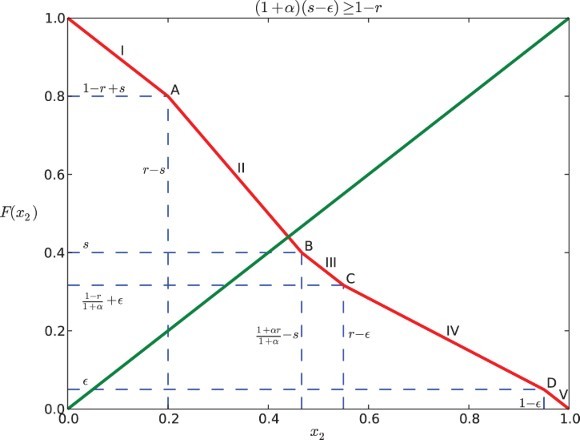
Return map F for Case II when α=0.5, s=0.4, r=0.6, and ε=0.05.